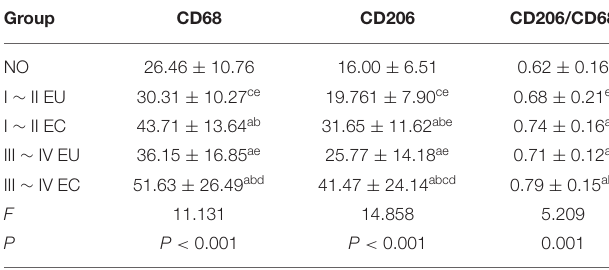
TABLE 6 | Comparison of IHC